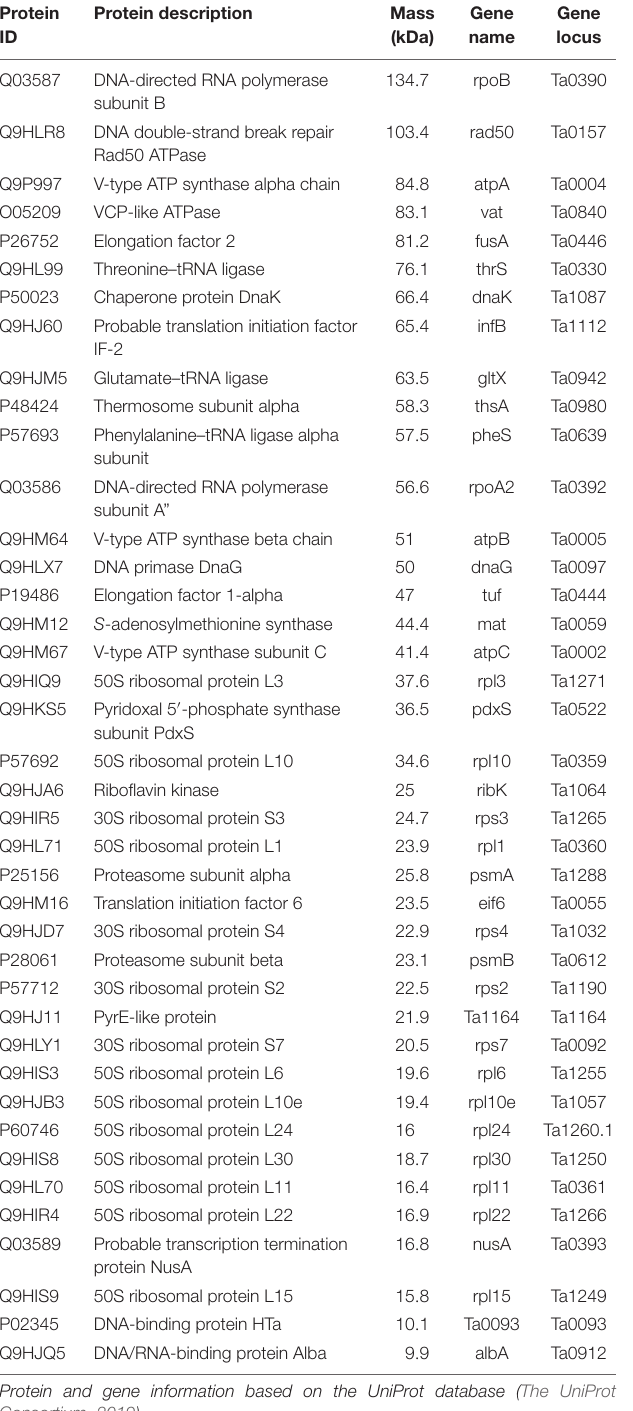
TABLE 2 | Proteins identified by mass spectrometry from isolated chromosomes of Pyrobaculum calidifontis. Protein Protein ID